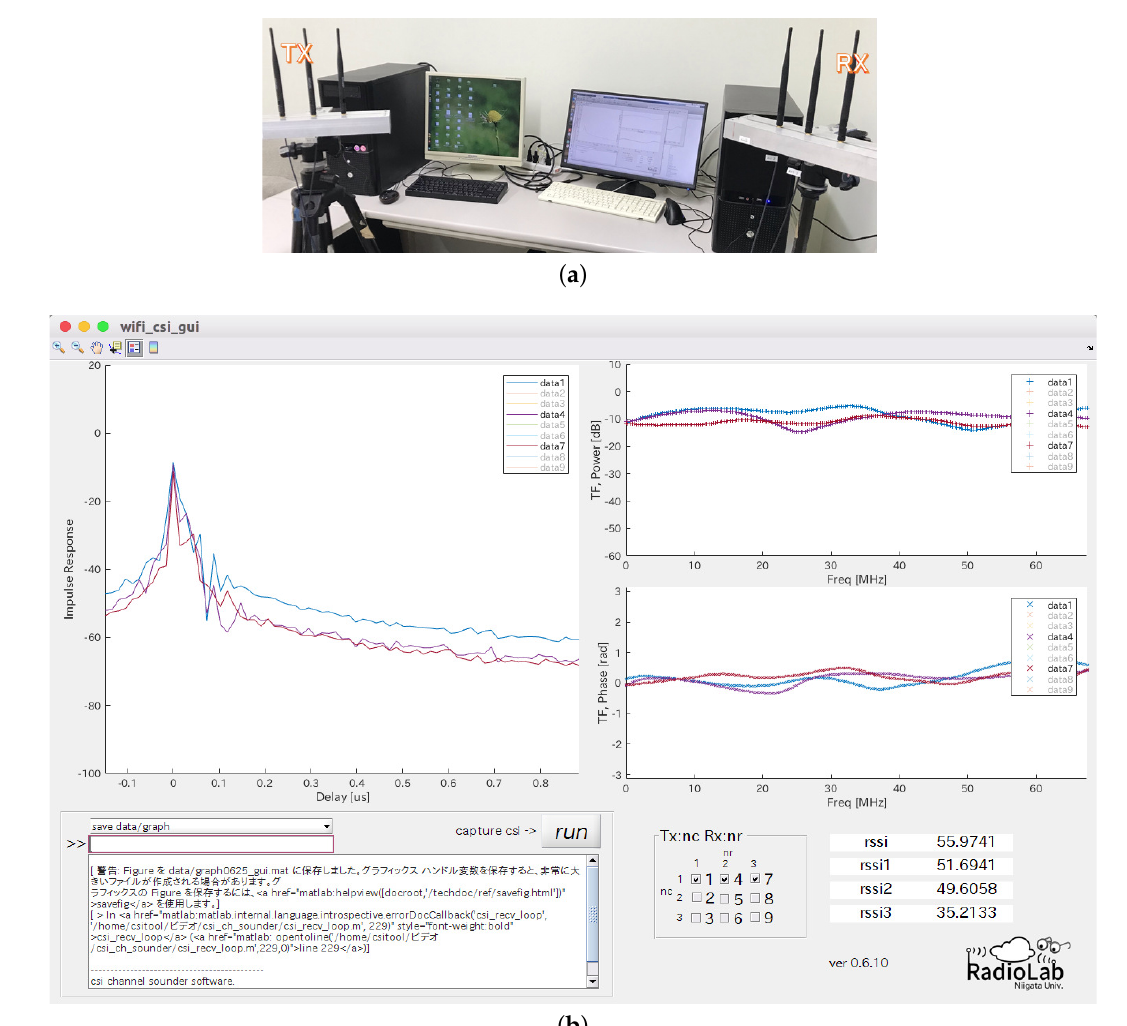
Figure 5. Developed channel sounding system. ( a ) Hardware setup. ( b )